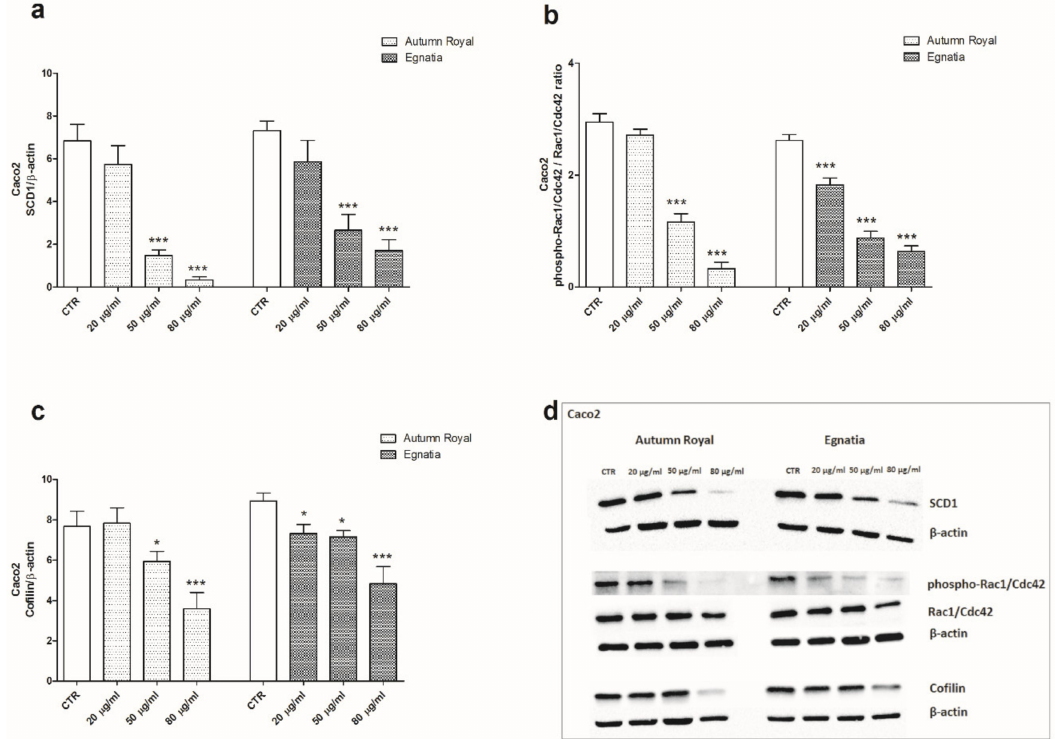
Figure 3. ( a ) SCD1 protein expression levels detected in Caco2 cell line treated with increasing concentration of Autumn Royal and Egnatia GSEs (20, 50, and 80 µ g / mL), after 48 h of incubation; ( b ) Phospho-Rac1 / Cdc42 / Rac1 / Cdc42 ratio expression levels detected in Caco2 cell line treated with increasing concentration of Autumn Royal and Egnatia GSEs (20, 50, and 80 µ g / mL), after 48 h of incubation; ( c ) Cofilin protein expression levels detected in Caco2 cell line treated with increasing concentration of Autumn Royal and Egnatia GSEs (20, 50, and 80 µ g / mL), after 48 h of incubation. All data are expressed as mean ± Standard Deviation (SD) of three di ff erent experiments. p -value was determined by ANOVA with Dunnett’s post-test. * p < 0.05 and *** p < 0.01 versus the control group (CTR). ( d ) Representative blots evaluated in Caco2 cells after Autumn Royal and Egnatia treatment. In SW480 cells, GSEs treatments exerted the same inhibitory e ff ects on phospho-Rac1 / Cdc42 / Rac1 / Cdc42 ratio protein expression starting from the dose of 50 µ g /